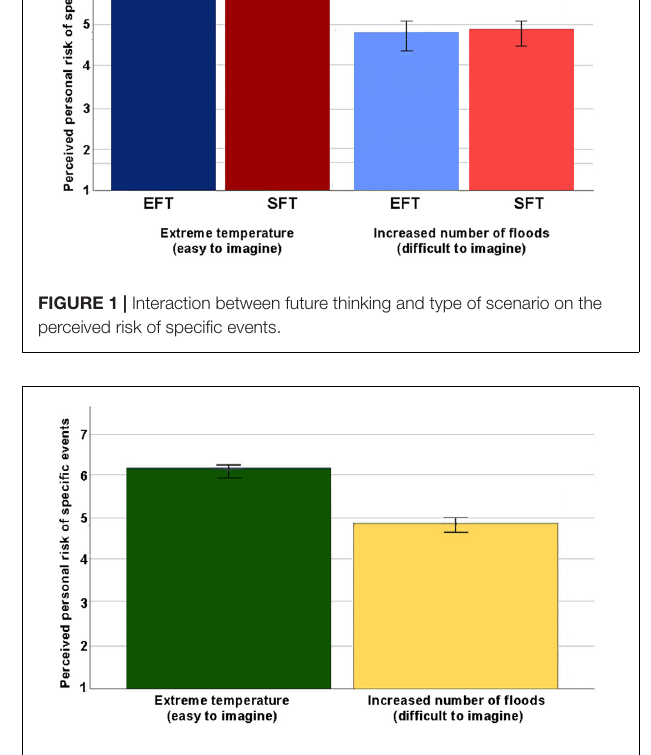
FIGURE 2 | Main effect of type of scenario on the perceived risk of specific